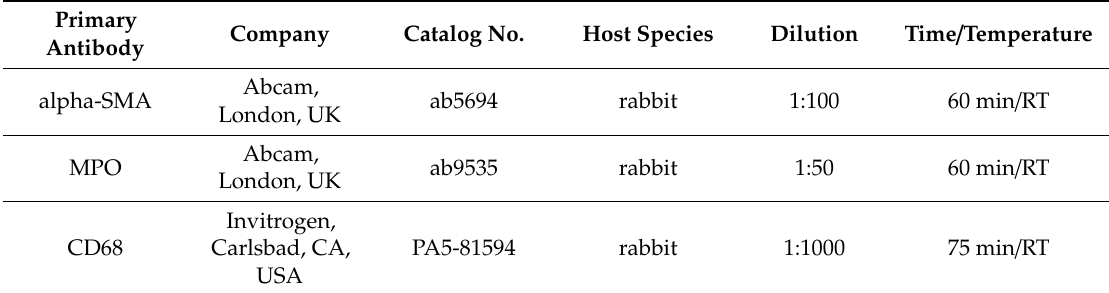
Table 3. List of antibodies used for immunohistochemical